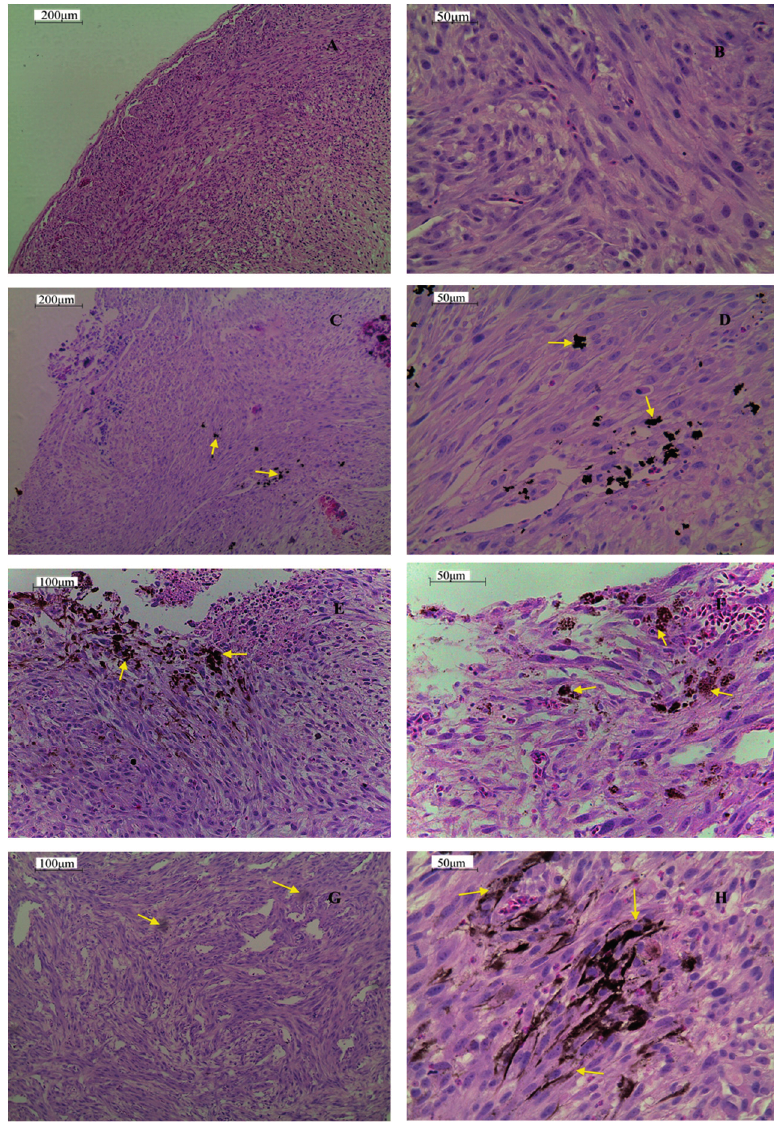
Figure 8. Histology of U-87 glioblastoma tumors cultured on chicken embryo chorioallantoic membranes in the control group ( A , B ) and after treatment with reduced graphene oxide ( C , D ); reduced graphene oxide with arginine ( E , F ); and reduced graphene oxide with proline ( G , H ). Arrows point to nanoparticles. Note: Reduced graphene oxide flakes formed